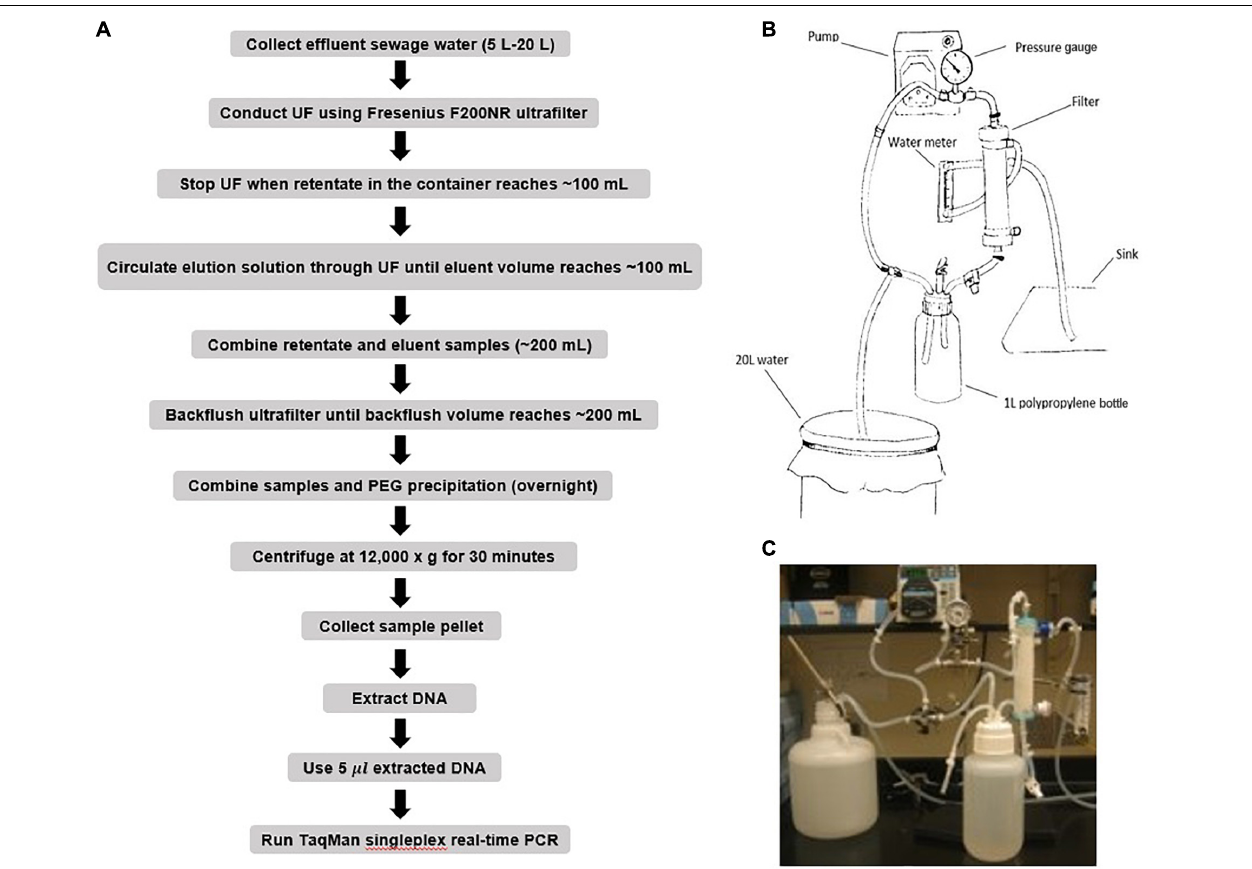
FIGURE 1 | Ultrafiltration method for recovering seeded S. Typhi and S. Paratyphi A from wastewater samples. (A) Flow diagram showing procedures for ST/SPA concentration and detection from seeded wastewater or field samples. (B) Schematic of hollow-fiber ultrafiltration setup. (C) Hollow-fiber ultrafiltration laboratory